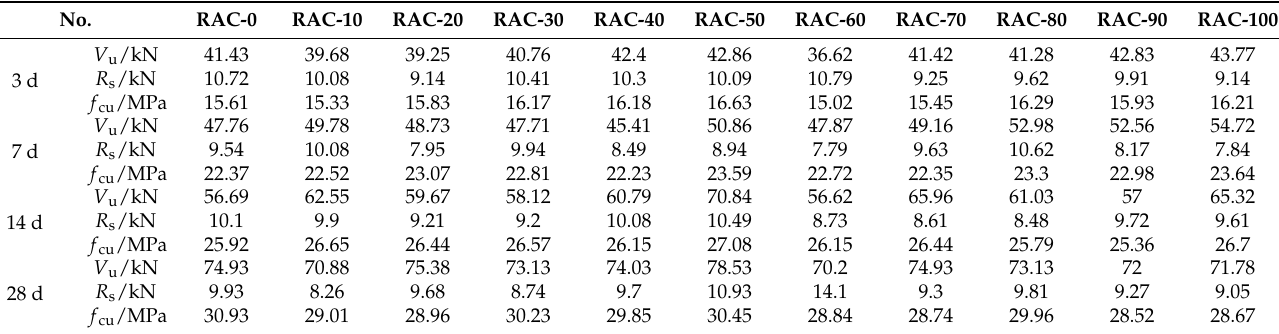
Table 3. Characteristic parameters of